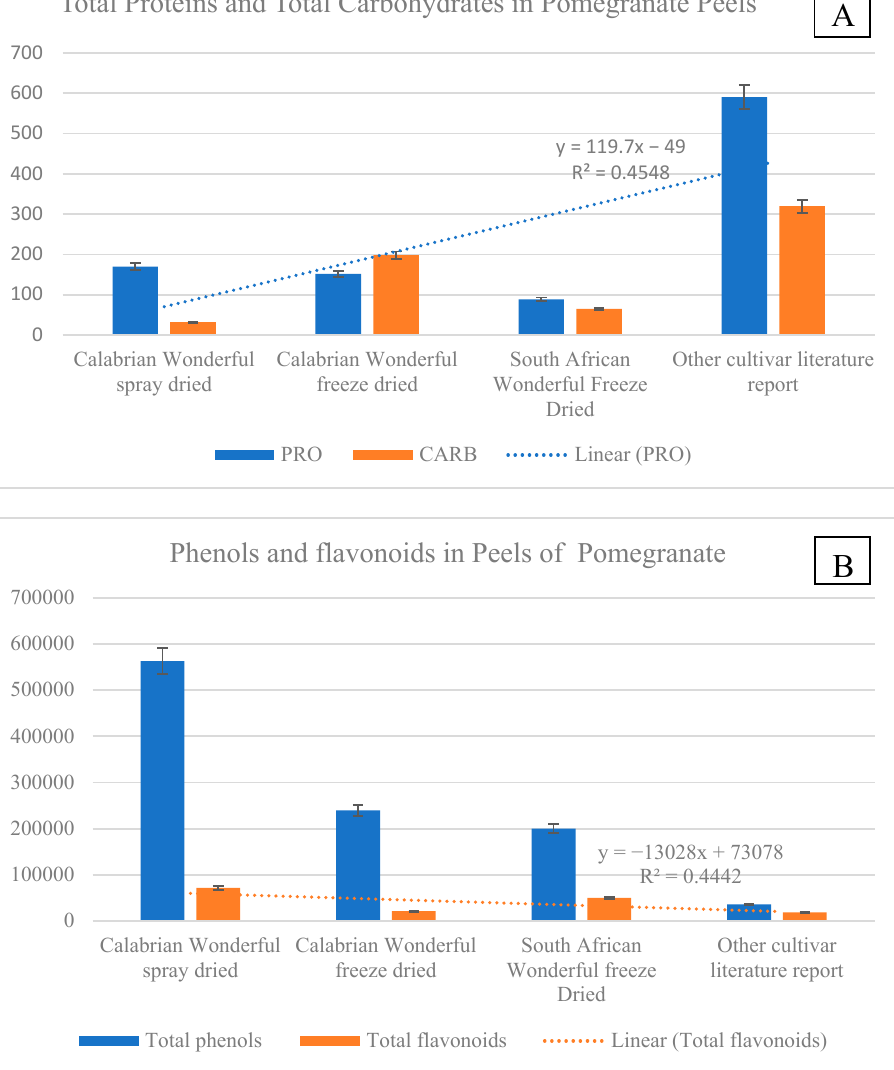
Figure 1. Soluble proteins and total carbohydrates ( A ) and total phenols and total flavonoids ( B ) in peels of different pomegranate cultivars dried differently. PSD (spray-dried Wonderful peel, experimental data); CFD (Calabrian Wonderful peel freeze-dried, experimental data); SAFD (South African Wonderful peel freeze-dried, literature data); IC (Indian cultivar peel freeze-dried, literature data). The experimental data are the mean of six replicates. Soluble protein (mg BSE g − 1 DW), carbohydrates (mg g − 1 DW), total phenols (µg TAE g − 1 DW), total flavonoids (µg quercetin g − 1 DW).